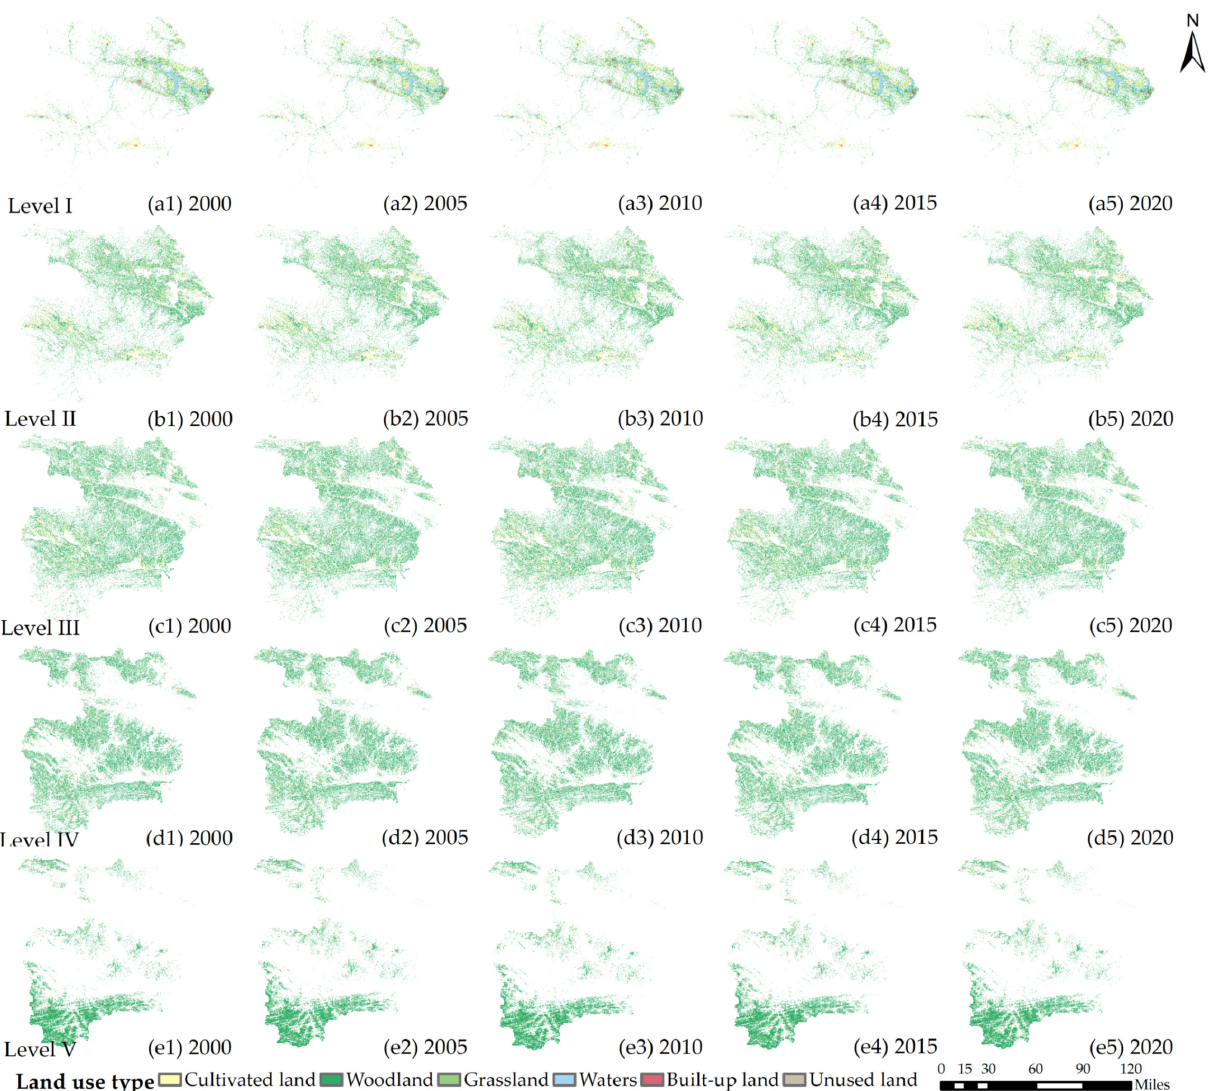
Figure 11. Land use change shown for each terrain index level in Shiyan from 2000 to 2020. Level I: ( a1 ) 2000, ( a2 ) 2005, ( a3 ) 2010, ( a4 ) 2015, and ( a5 ) 2020; level II: ( b1 ) 2000, ( b2 ) 2005, ( b3 ) 2010, ( b4 ) 2015, and ( b5 ) 2020; level III: ( c1 ) 2000, ( c2 ) 2005, ( c3 ) 2010, ( c4 ) 2015, and ( c5 ) 2020; level IV: ( d1 ) 2000, ( d2 ) 2005, ( d3 ) 2010, ( d4 ) 2015, and ( d5 ) 2020; level V: ( e1 ) 2000, ( e2 ) 2005, ( e3 ) 2010, ( e4 ) 2015, and ( e5 ) 2020.